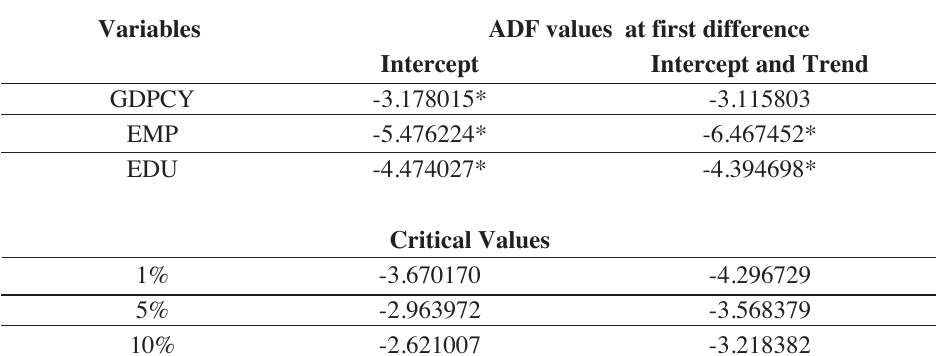
Table 2: Results of ADF at first